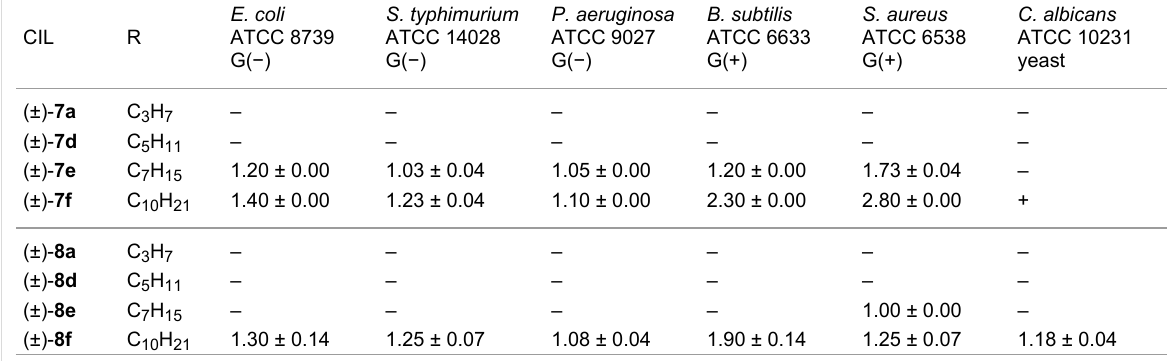
Table 4: Growth inhibition halo (cm) for the racemic imidazolium and triazolium CILs (25 mM).